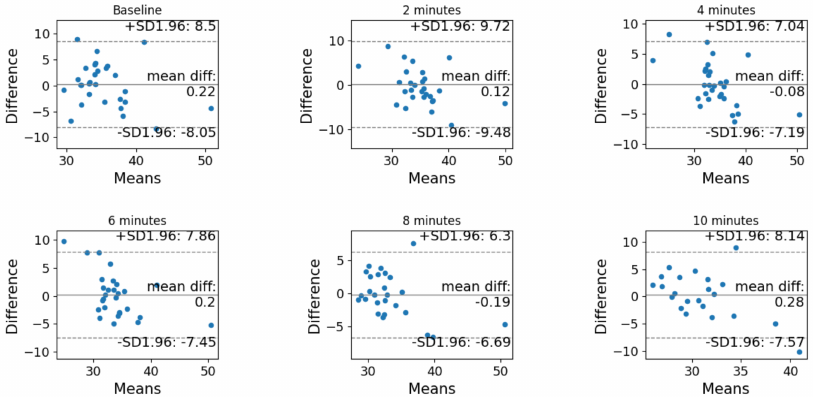
Figure 4. Bland–Altman analysis of the agreement between PtCO 2 and PaCO 2 after the correction at each timestamp (baseline, after 2 min, after 4 min, after 6 min, after 8 min and after 10